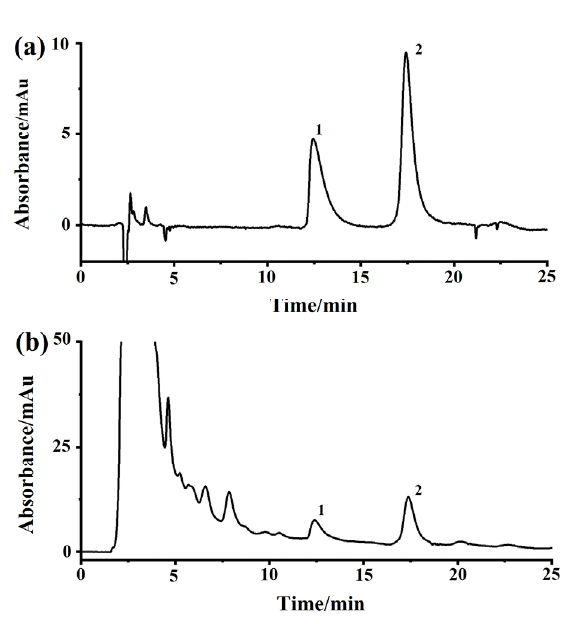
Figure 9. Representative chromatograms of Daturae Flos extract on a reversed-phase column with a detection wavelength of 216 nm. ( a ) Reference standards of atropine sulfate and ( − )-scopolamine hydrochloride. ( b ) Extract of Daturae Flos ; 1, atropine sulfate; 2, ( − )-scopolamine hydrochloride.